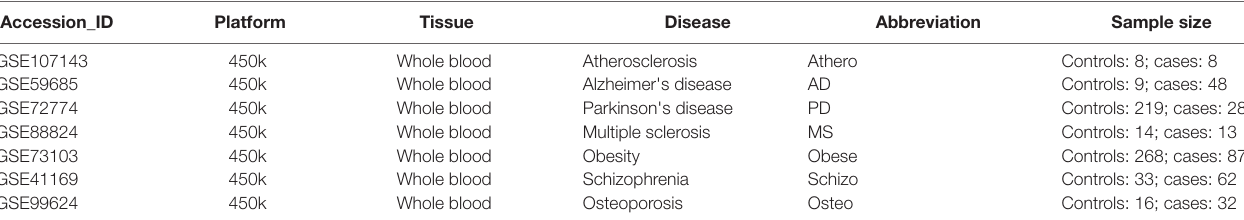
TABle 2 | Gene Expression Omnibus whole blood methylation datasets of different inflammaging diseases.